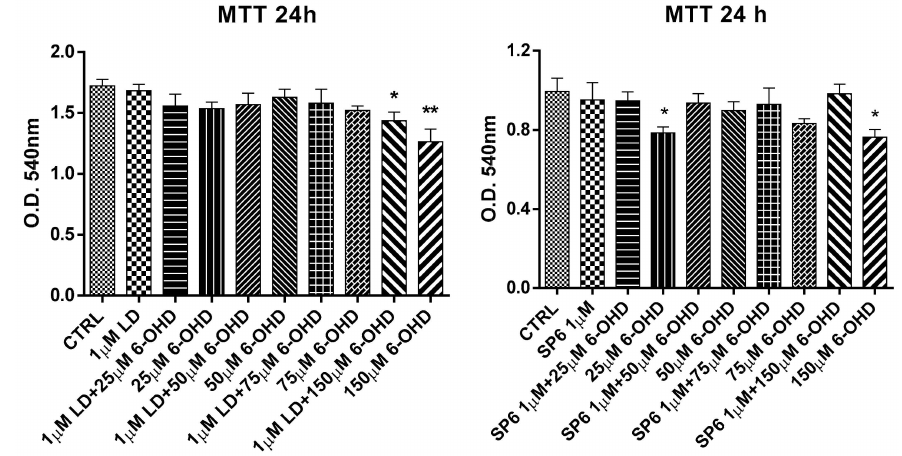
Figure 6. Neuroprotective e ff ect of LD and SP6 against 6-OHDA in RA / PMA-di ff erentiated SH-SY5Y human neuroblastoma cells. The MTT reduction assay in RA / PMA-di ff erentiated and 6-OHDA-lesioned SH-SY5Y human neuroblastoma cells in the presence of LD and SP6 . The cells were incubated with the compounds (1 µ M) 1 h before and during a 24 h incubation period with increasing concentrations (25, 50, 75, and 150 µ M) of 6-OHDA. After this period, cell viability was quantified by measuring the MTT reduction. CTRL: control without compounds. The means ± SEM derived from three di ff erent experiments (each with n = 16; ** 0.0005 < p < 0.001; * 0.001 < p < 0.05; n.s., p > 0.05). Furthermore, the di ff erentiated cells with RA / PMA were lesioned with increasing concentrations (25, 150, 300 µ M) of H 2 O 2 (Figure 7). Data showed that SP6 was e ff ective in countering the toxic e ff ect 300 µ M H 2 O 2 .